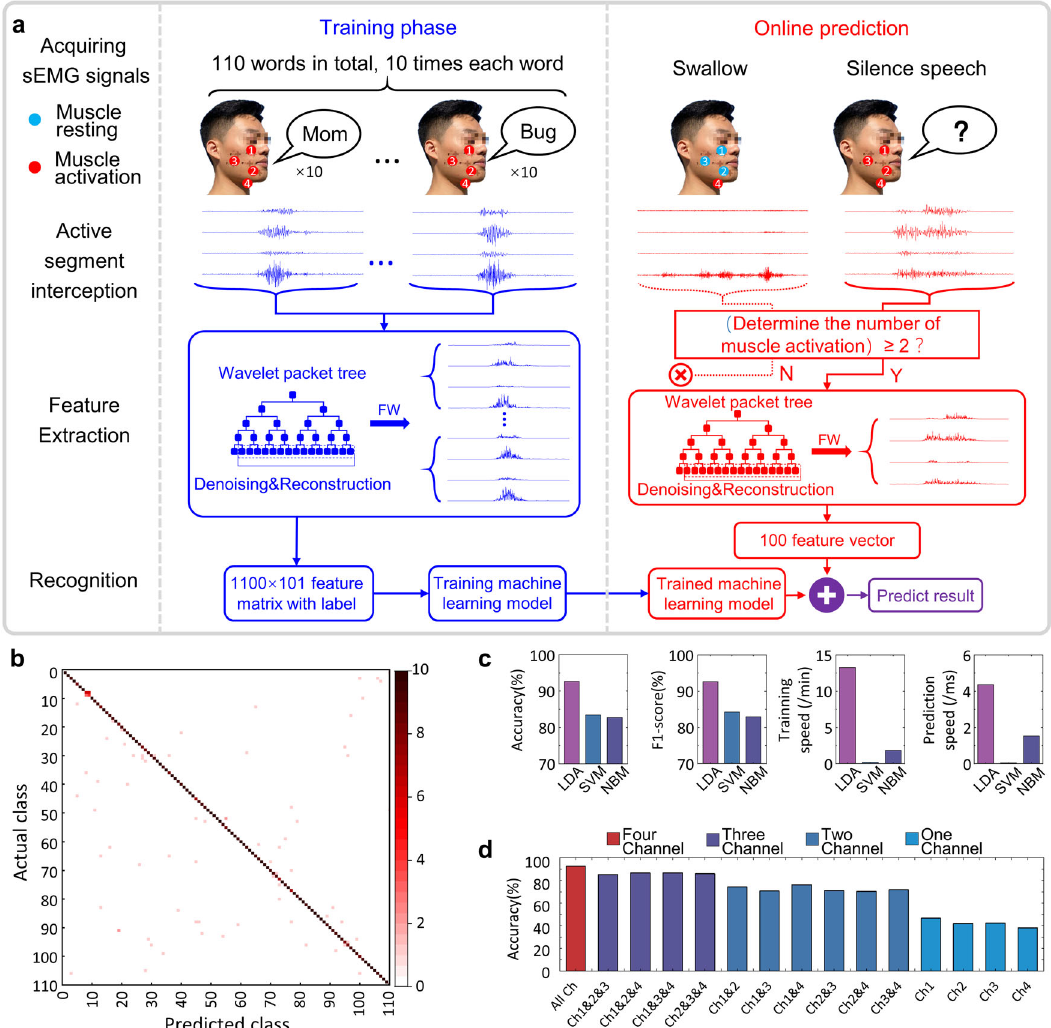
Fig. 3 Flow chart and the evaluation of silent speech recognition system. a Recognition fl ow chart of training phase (left) and online prediction (right). The identi fi able photographs are fully consented by the written consents. b Confusion matrix of recognition results of 110 ASL words. c Prediction performance of different classi fi ers LDA, SVM, and NBM. d Accuracy rate from multiple channels to a single